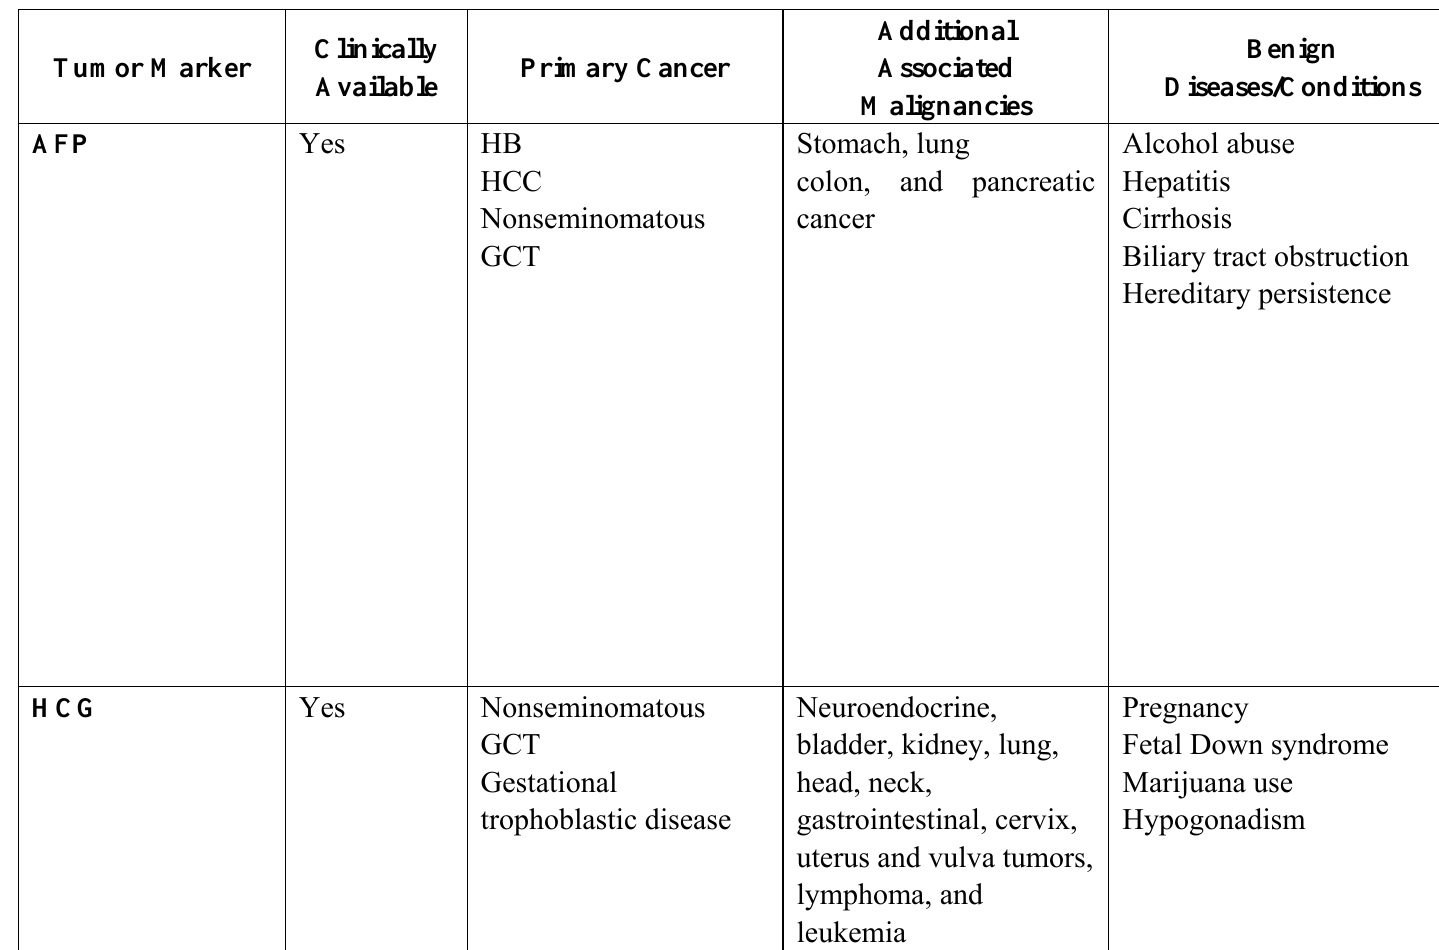
Table 1. Serum markers in pediatric solid